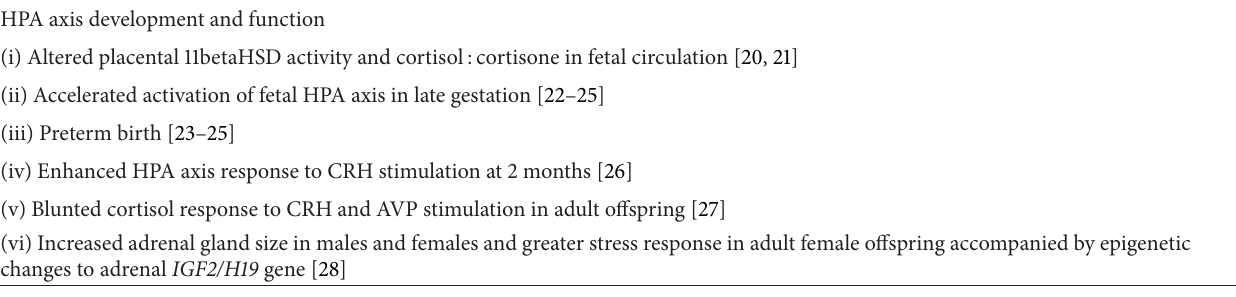
Table 1: Summary of animal study findings associated with periconception and early gestation maternal weight loss. HPA axis development and